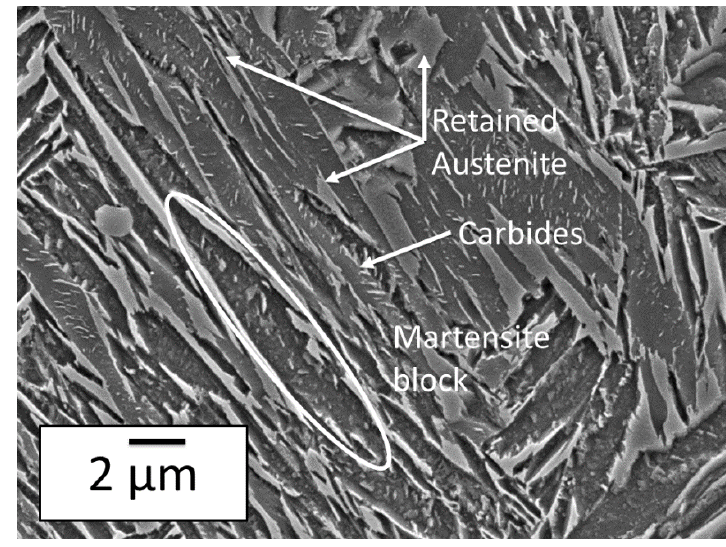
Figure 2. Scanning electron microscopy (SEM) micrograph of the studied steel after Q&P heat treatment (state 8). Etching has dissolved the tempered martensitic matrix preferentially. Intralath carbides and interlath retained austenite thus appear in clear contrast. A martensite block is also highlighted.